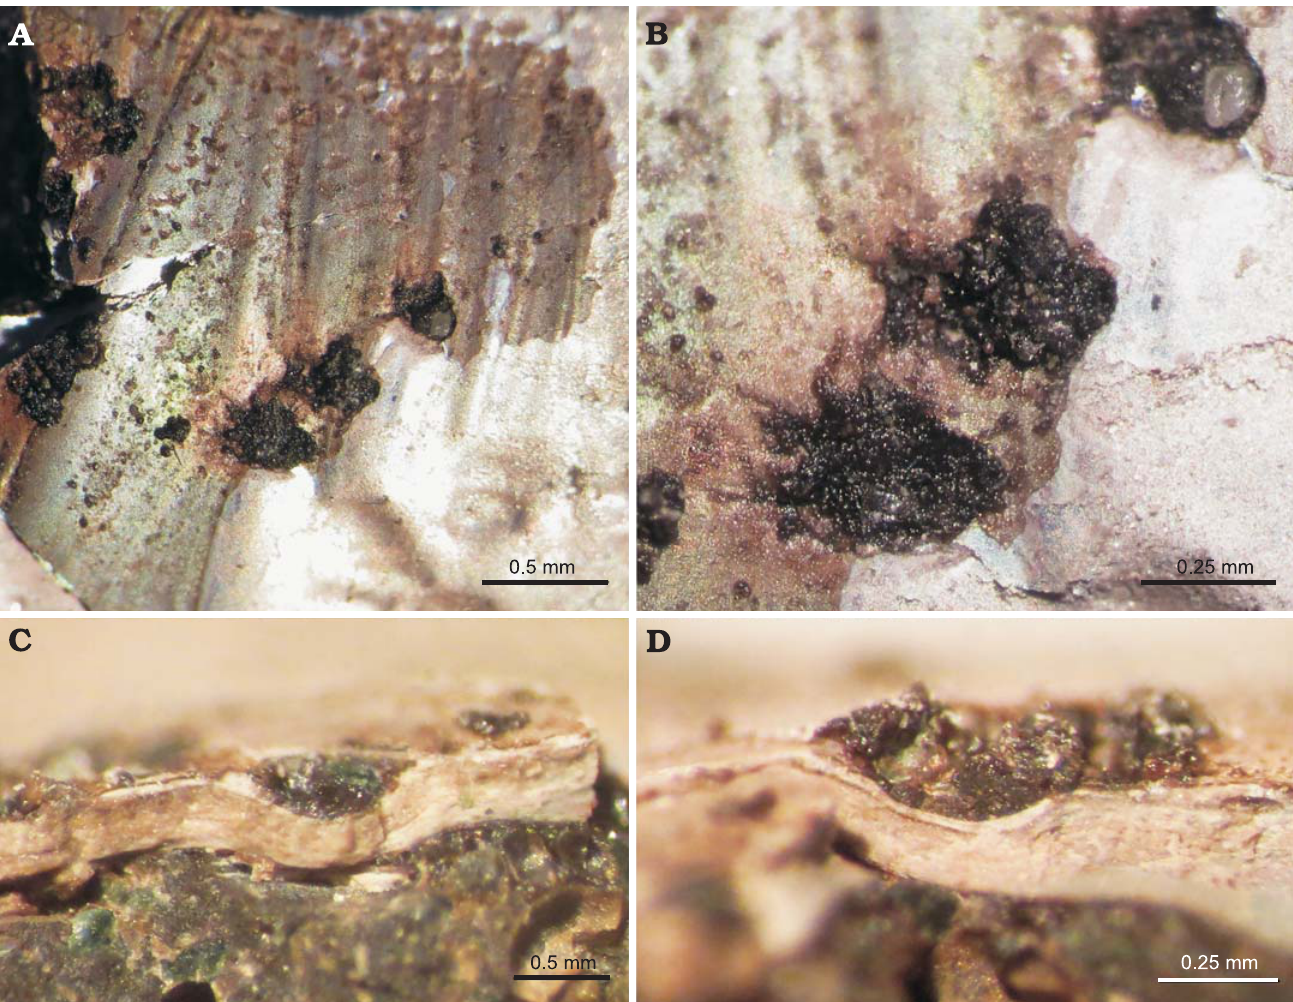
Fig. 7. The pits with preserved phosphatic remnants on the shell of craspeditid ammonite Kachpurites fulgens (Trautschold, 1861) from the Late Volgian, Kachpurites fulgens Zone, Moscow region, Eganovo locality, Central Russia; MSU 118/1. A , B . Three pits with phosphatic filling on the well-preserved surface of the specimen. C , D . Transverse cross-sections of the two pits with phosphatic remnants located on the well-preserved part of the shell of the specimen. Note the thin outer prismatic and thick nacreous layers. The photos were taken using an optical binocular